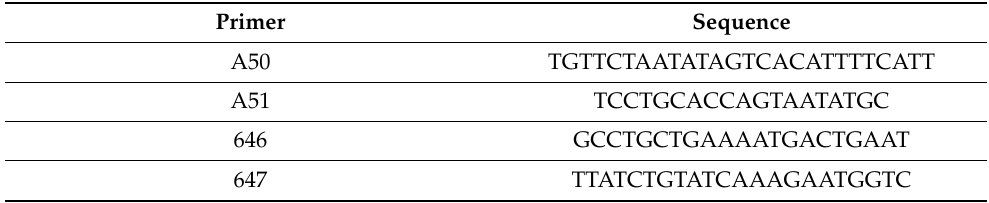
Table 1. KRAS primers of amplification: k2, couples A50–A51;